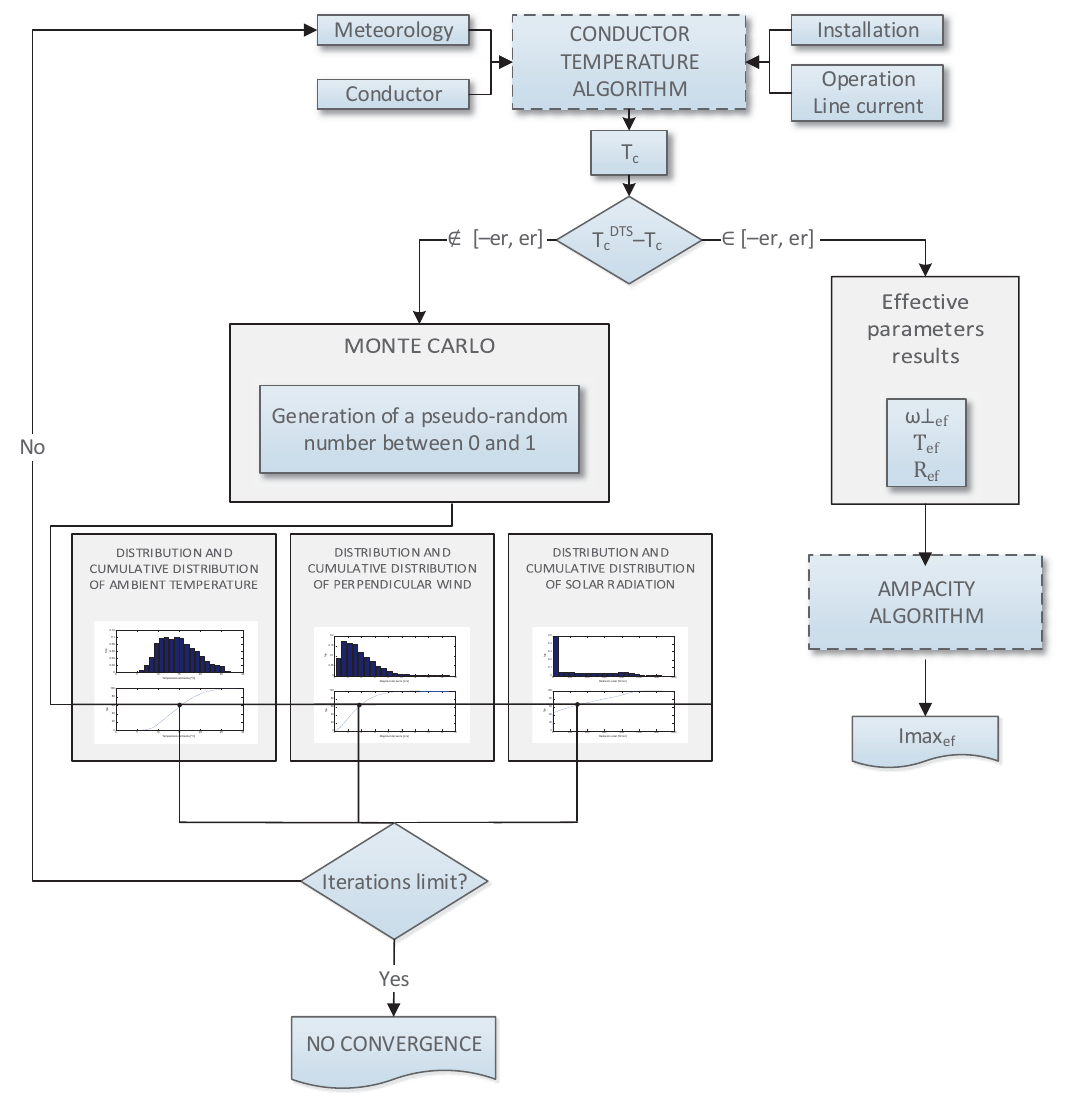
Figure 15. Monte Carlo method flow